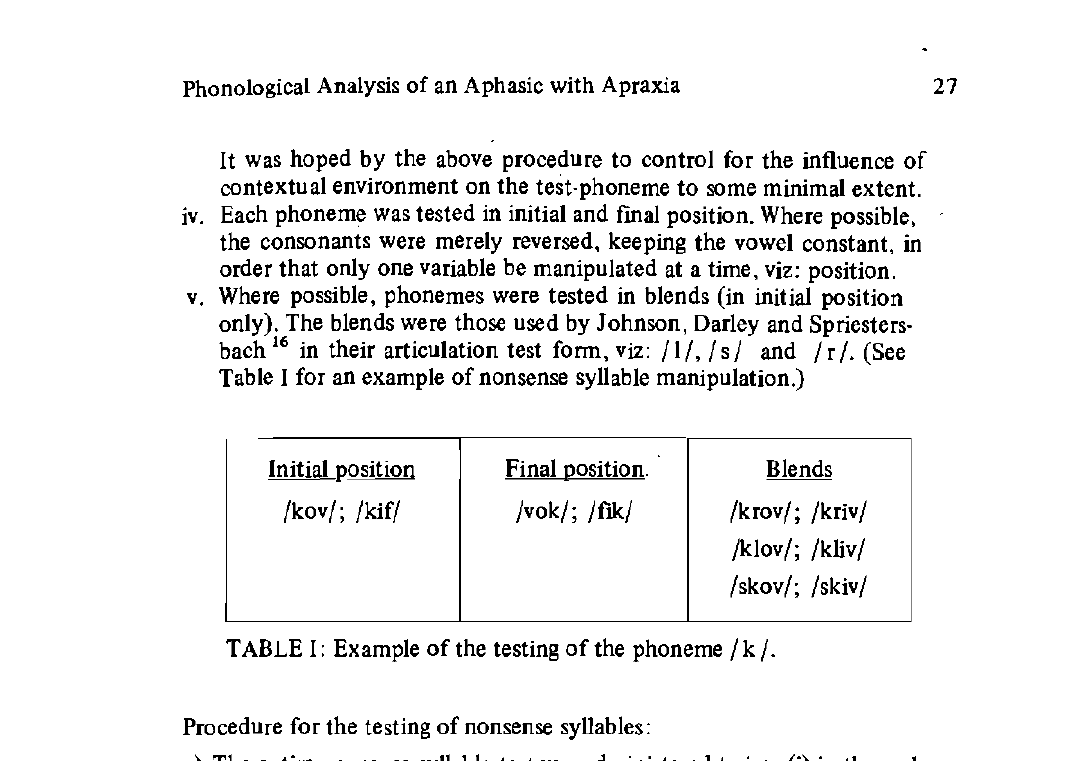
TABLE I: Example of the testing of the phoneme /k/. Procedure for the testing of nonsense